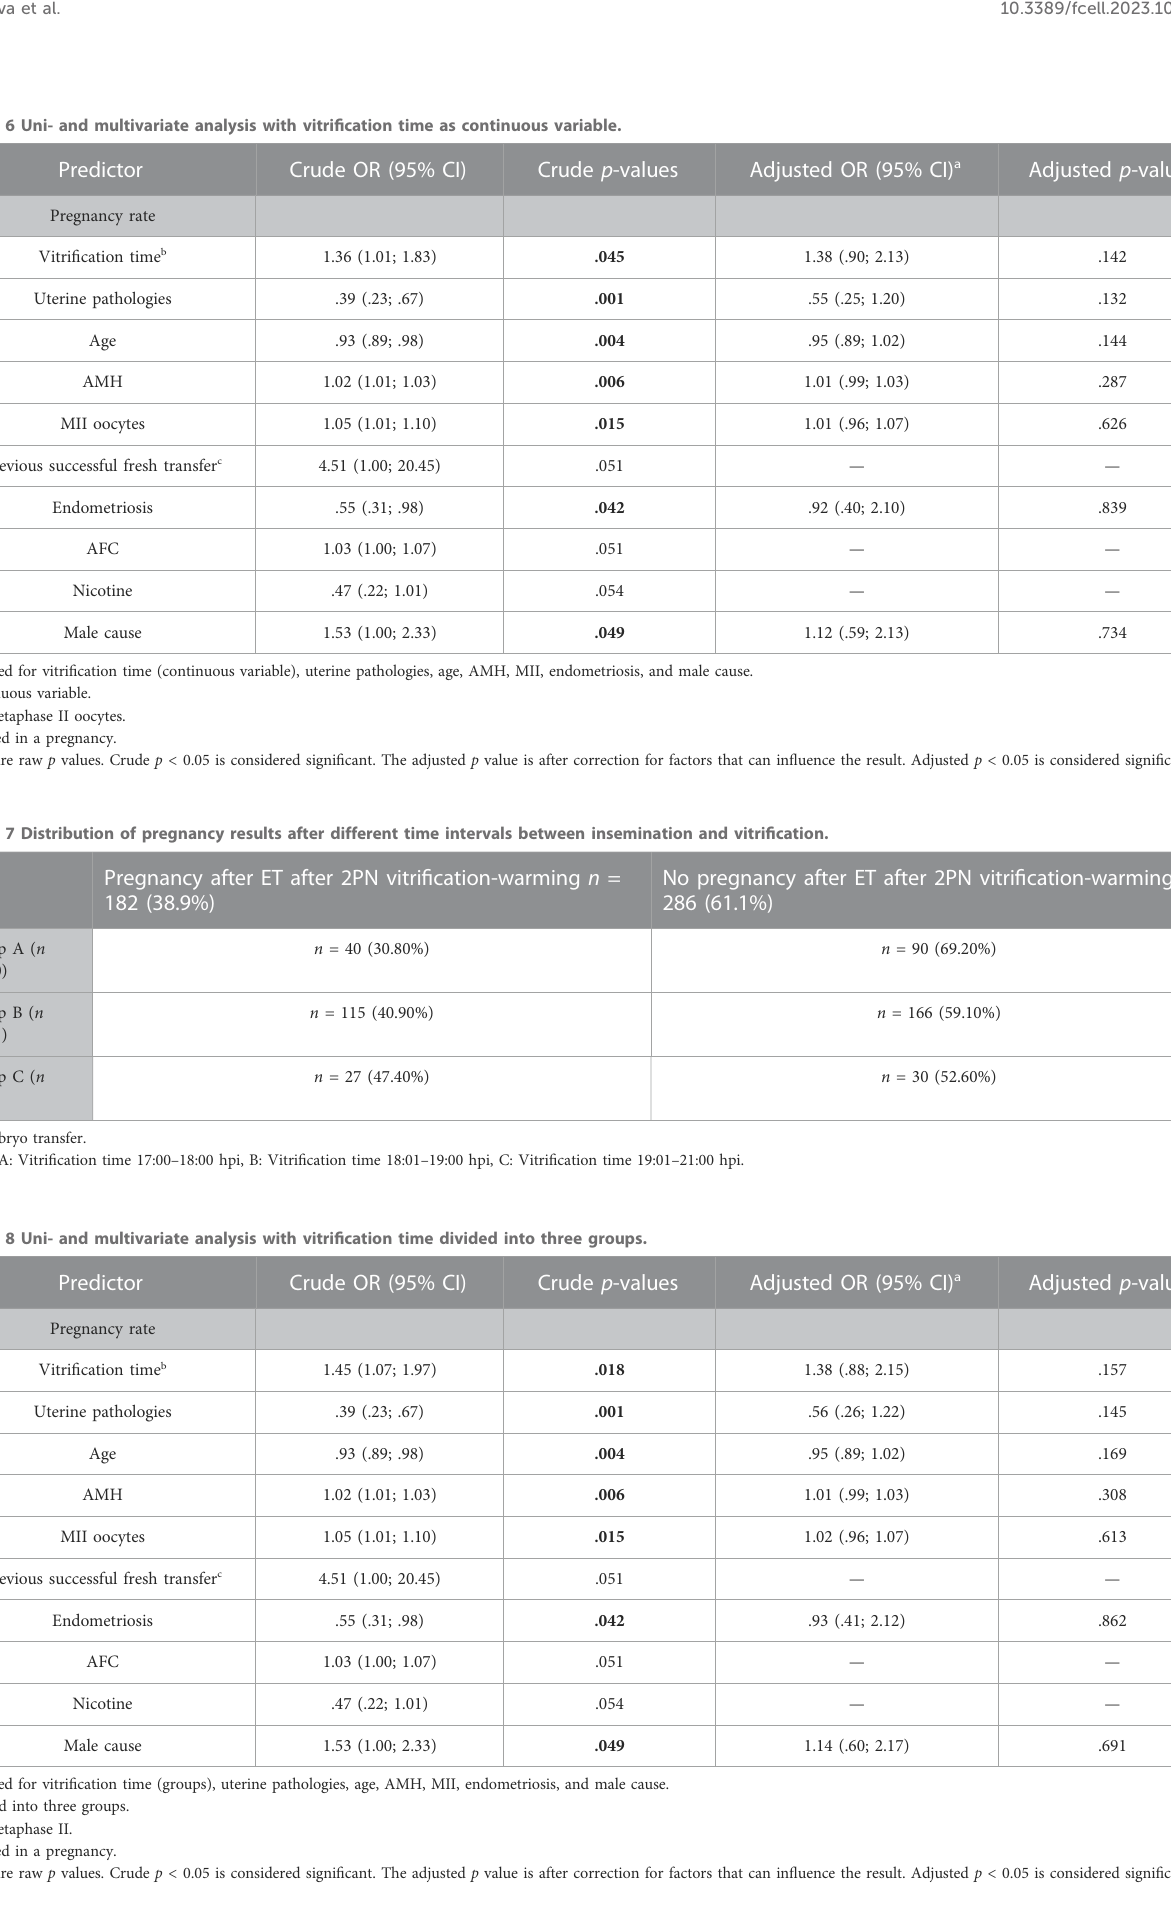
Previous successful fresh transfer c 4.51 (1.00;